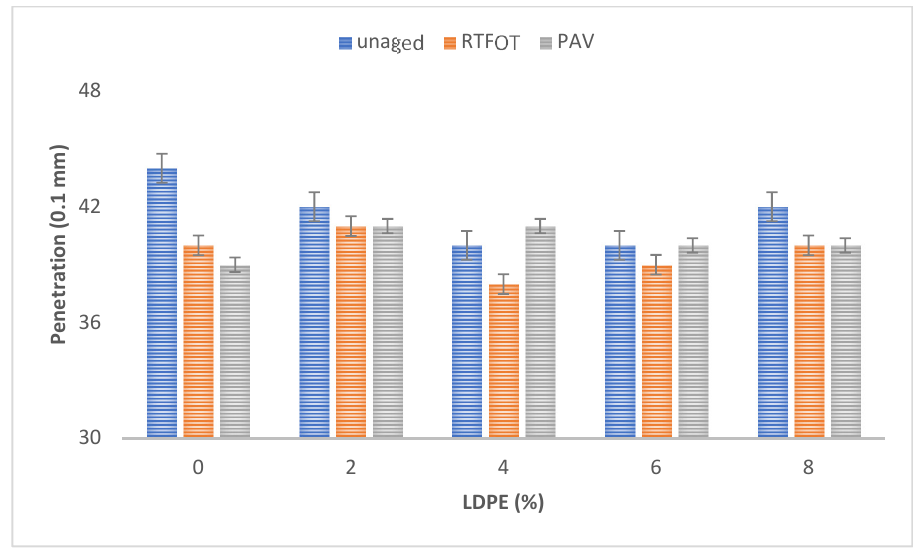
Figure 8. Penetration results for LDPE-modified bitumen after the RTFOT and PAV tests.